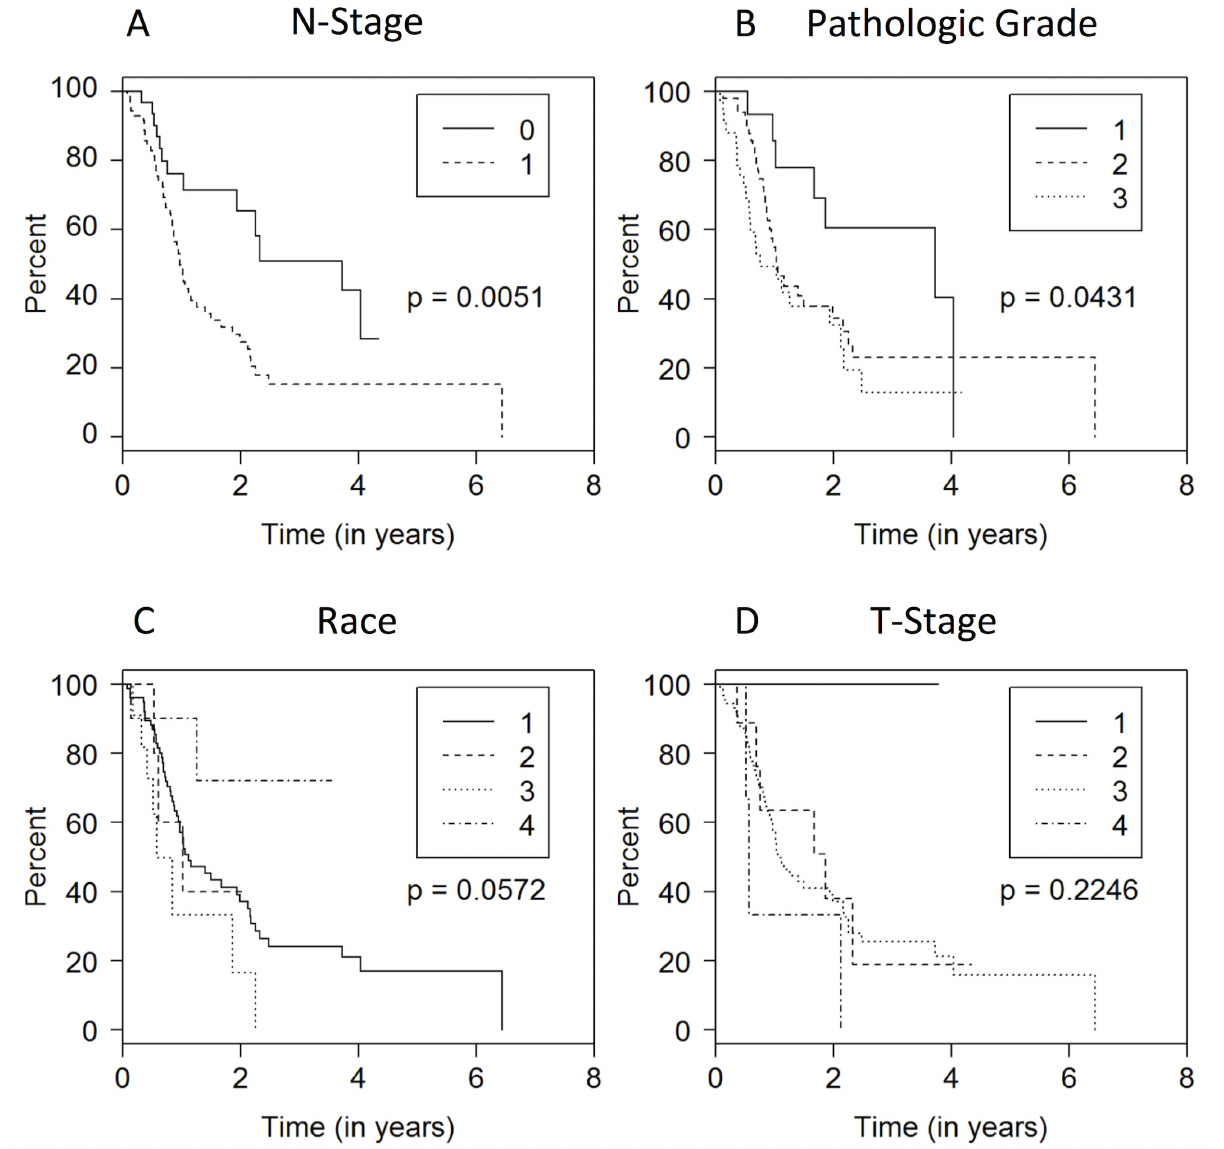
Fig 1. Patient and disease factors associated with disease free survival. (A) Disease Free Survival with Node Stage 0 (0) vs Node Stage 1 (1). (B) Disease Free Survival of histologic Grade utilizing three tier grading (1: well differentiated, 2: intermediate differentiation, poorly differentiated). (C) Disease Free Survival Among various races (1: Caucasian, 2: African American, 3: Asian, 4: Hispanic). (D) Disease Free Survival Across Tumor Stage (T1-T4).